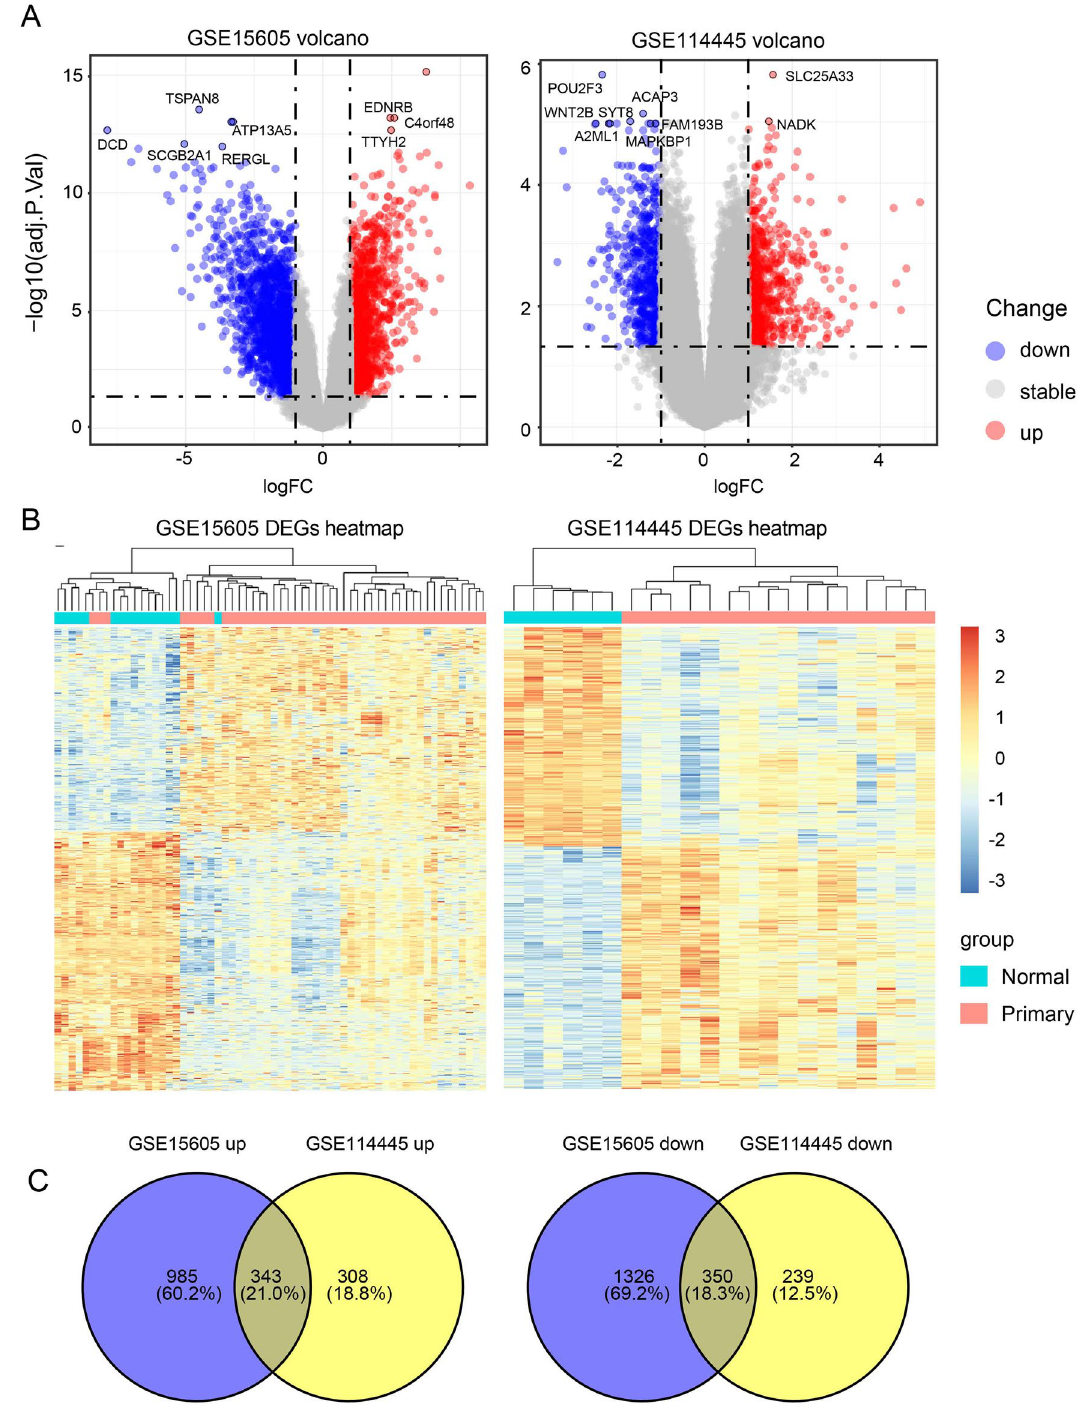
Figure 1. Screening results of DEGs. ( A ) A volcano map of DEGs in the GSE15605 and GSE114445 data sets. The red, blue, and gray points represent genes that were upregulated, downregulated, and showed no significant differences in expression, respectively. ( B ) Heat map of differential gene expression in the GSE15605 and GSE114445 datasets. ( C ) A Venn diagram displaying the number of DEGs in the two datasets from the GEO database. DEG differentially expressed gene, down downregulated, up upregulated, stable no difference in